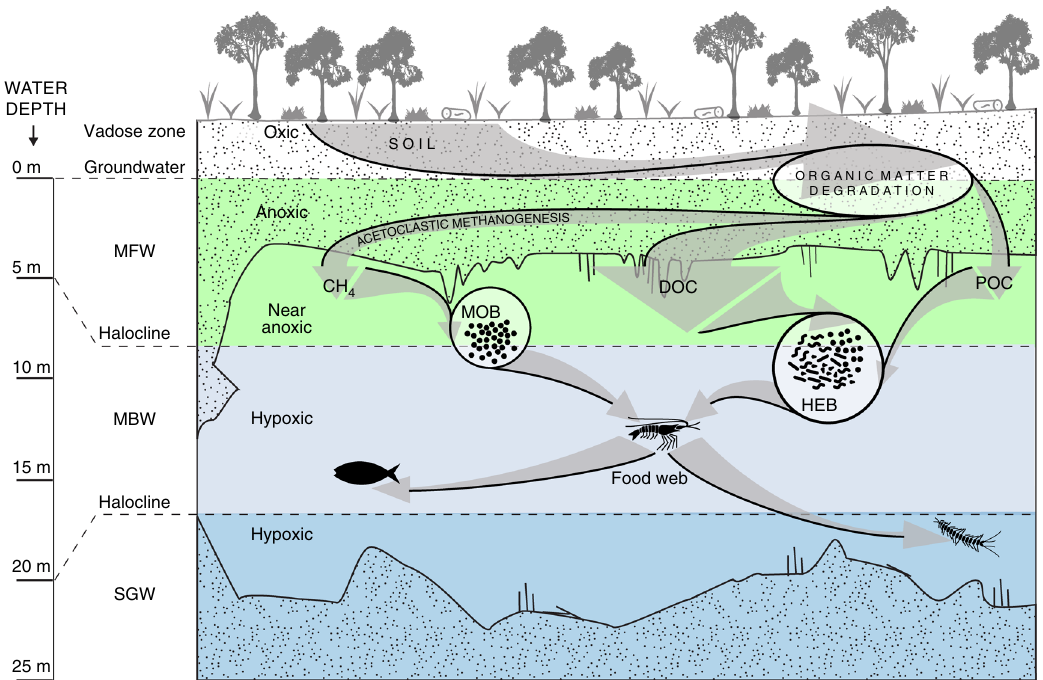
Fig. 6 Conceptual model for a terrestrially in fl uenced tropical karst subterranean estuary microbial loop. Dissolved organic carbon (DOC) and methane (CH 4 ) produced from soil organic matter degradation within the shallow and anoxic saturated zone of the carbonate rock-matrix are transported into hypoxic cave conduits, where methane oxidizing bacteria (MOB) and heterotrophic bacteria (HEB) consume these reduced forms of organic carbon. Bacterial biomass is assimilated by fi lter-feeding crustaceans that are, in turn, preyed upon by higher trophic levels of the food web in this anchialine